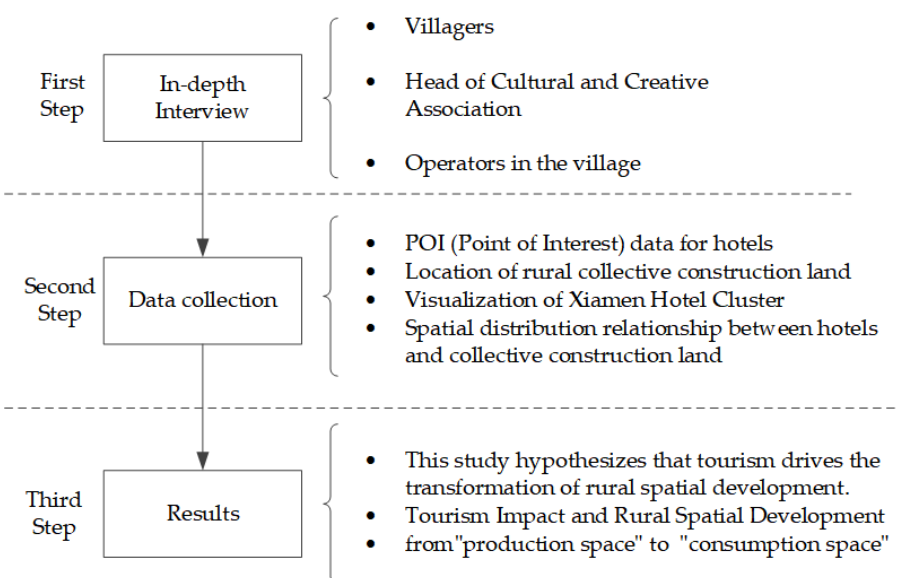
Figure 2. Research Methodology and Process. (Source: drawn by the authors).